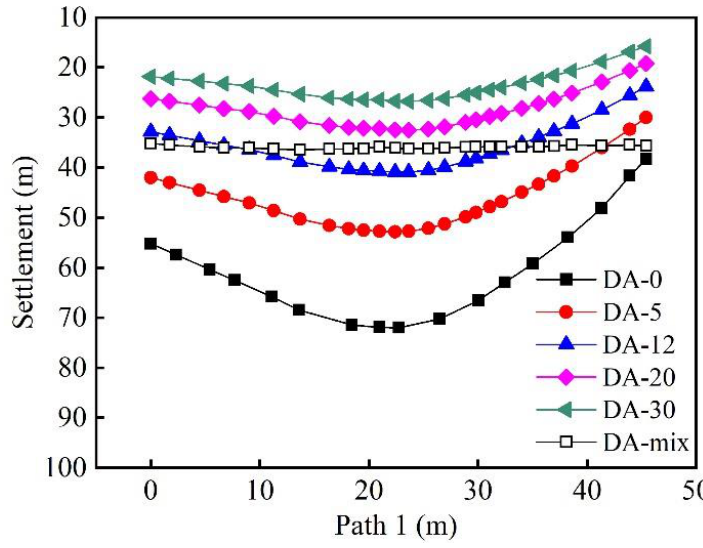
Figure 8. Curve of raft settlement along path 1 .